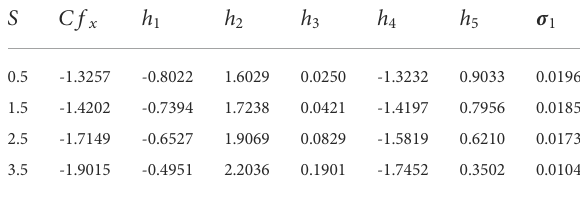
TABLE 5 Frictional factor ( Cf x ) and ideal relative error bound ( σ 1 ) for various values of suction ( S ) and speed slippage constraint ( ε ). S Cf